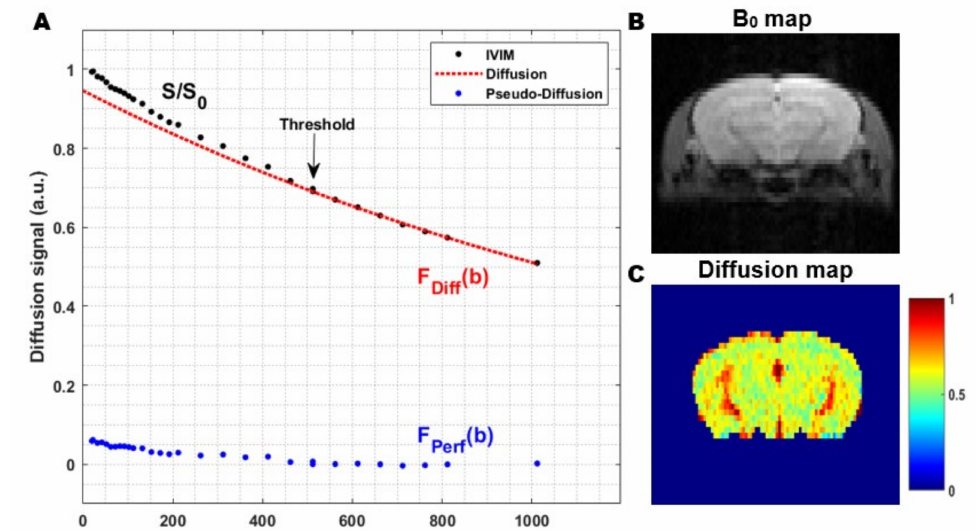
Figure 5. The general principle of the two-step fitting approach in Intravoxel Incoherent Motion (IVIM) MRI: ( A ) In a first step, the signal attenuation at high b-values is fitted (red). Since the signal attenuation at high b-values only contains contributions from the molecular diffusion of water in the extravascular-extracellular space (EES), this can be used to estimate the diffusion coefficient. In the second step, the data from all b-values are used to extract the other IVIM parameters. The contribution of the pseudo-diffusion in the microvascular network (blue) can be visualized by subtracting the diffusion contribution from the total IVIM signal (black-red); ( B ) Coronal B 0 map in a rat and; ( C ) Corresponding diffusion coefficient map, obtained from the first step in the two-step fitting approach. The images were acquired from a mouse brain using a single shot gradient